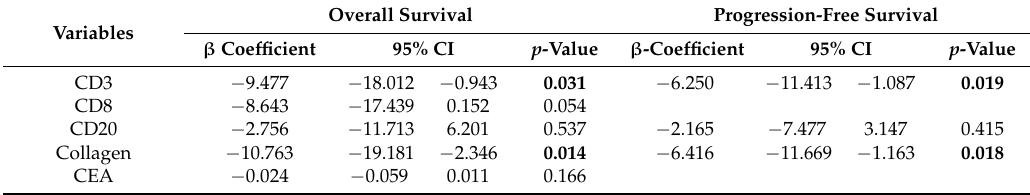
Table 5. Multivariate Analysis of Variables with p < 0.05 in the univariate analysis as a linear regression. Combination groups of different immune cell types were excluded due to possible statistical effects by double-use. p -values under 0.050 appear in bold ( n = 57). Significant p -values were bolded.